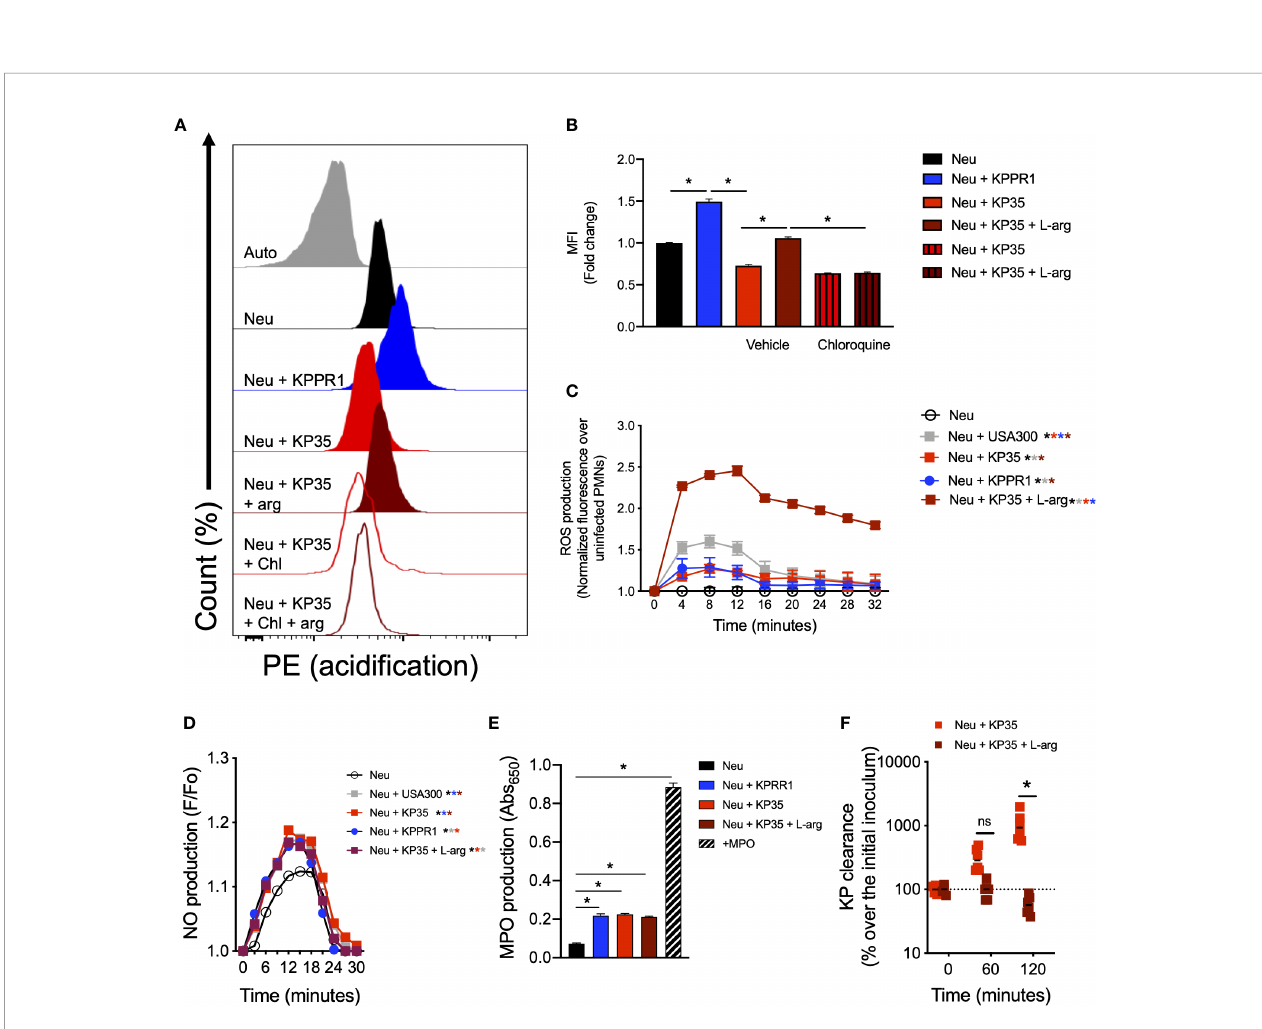
FIGURE 5 | L -arginine improves phagosome acidi fi cation, ROS production, NO consumption and KP35 killing by murine neutrophils. Neutrophils were treated with 200mg/L of L -arginine and infected with KP35. (A) Phagosome acidi fi cation was evaluated and (B) quanti fi ed by fl ow cytometry after 30 min. (C) ROS production was measured every 4 min for 32 min. In parallel, (D) NO production was recorded every 3 min for 30 min. (E) MPO production was analyzed after 30 min. (F) KP35 killing was evaluated in presence or absence L -arginine for 2h. (B, E) *P < 0.05, each group was compared using a one-way ANOVA test followed by a Tukey ’ s test for multiple comparisons. (C, D, F) *P < 0.05, each group was compared using a two-way ANOVA test followed by a Tukey ’ s test for multiple comparisons. ns, non signi fi